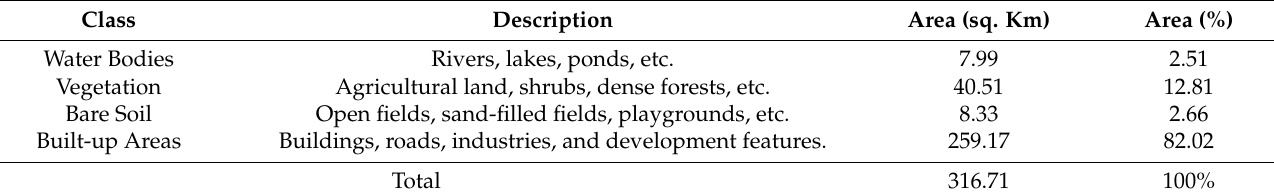
Table 3. Supervised classes for LULC with their area coverage and total percentage. Class Description Area (sq. Km) Area (%) Water Bodies Rivers, lakes, ponds,